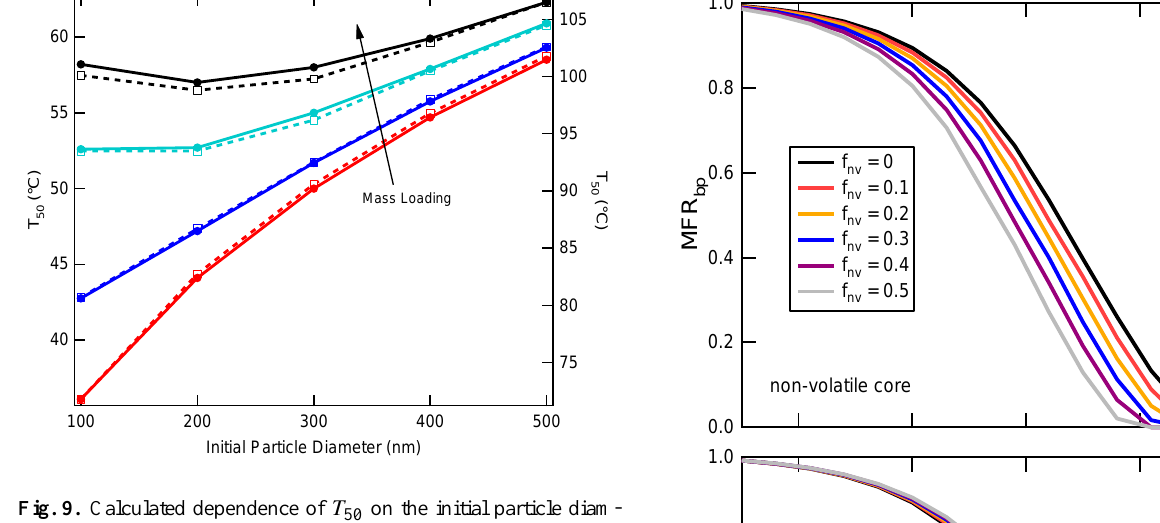
Fig. 9. Calculated dependence of T 50 on the initial particle diam- eter, d p , using the adsorbent denuder boundary condition (Case 1). The different color lines correspond to different aerosol mass load- ings (5µg/m 3 , 50µg/m 3 , 150µg/m 3 and 250µg/m 3 ) . The saturation concentrations used were either C sat =5µg/m 3 (solid lines, left axis) or C sat =0.1µg/m 3 (dashed lines, right axis). For these calculations,